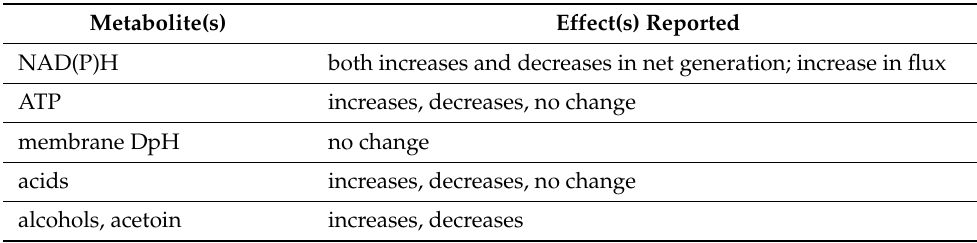
Table 1. Effect of VHb expression in heterologous bacteria on metabolism. Further information can be found in reference